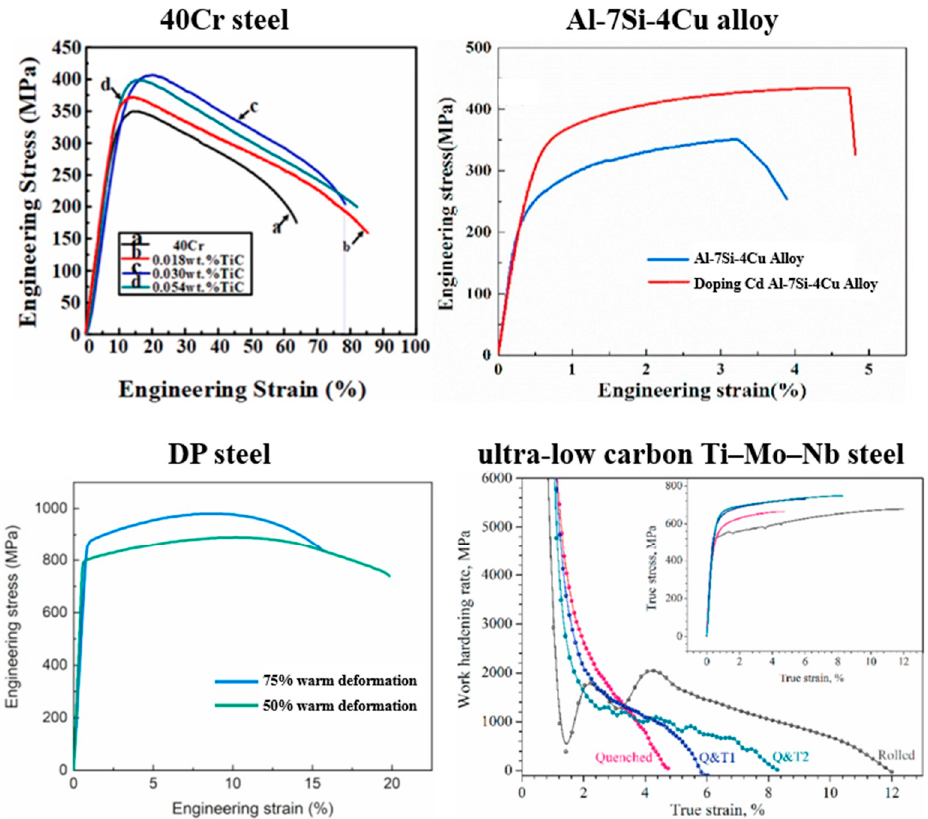
Figure 13. Engineering stress-strain curves/work hardening rate-true strain curves of metal materials with optimized properties. Reprinted with permission from ref. [42,45,48,106], Copyright 2022 Elsevier.